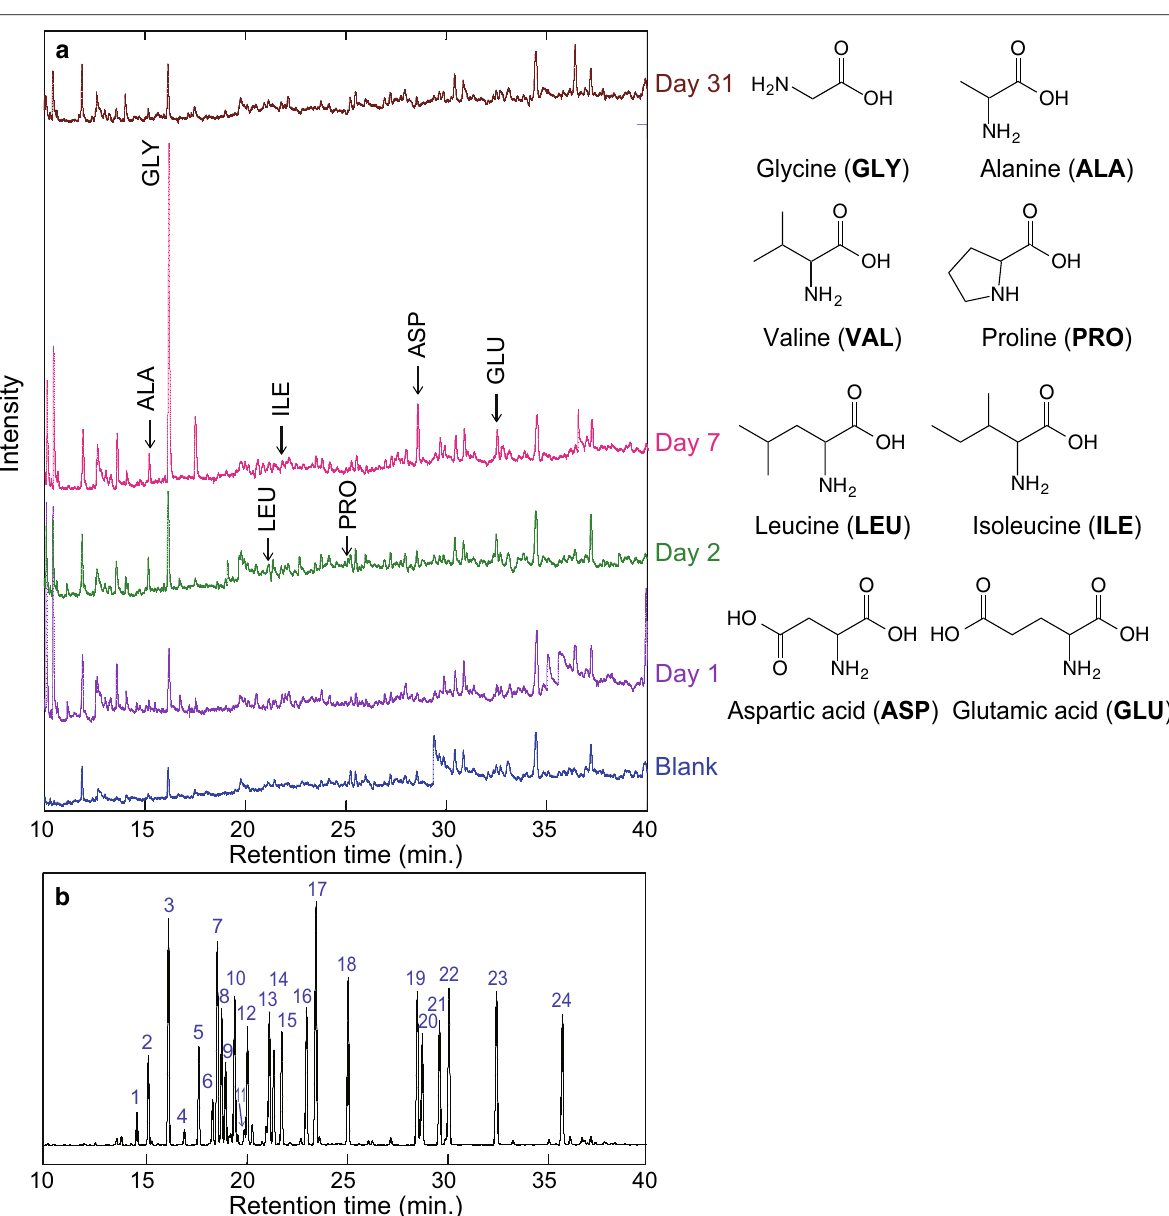
Fig. 3 a GC/NPD chromatograms of the witness coupons and chemical structures of the detected amino acids. b GC/NPD chromatograms of the authentic amino acid standards. The numbered peaks refer to the following: 1. α-aminoisobutyric acid; 2. α-alanine; 3. glycine; 4. isovaline; 5. α-aminobutyric acid; 6. sarcosine; 7. β-alanine; 8. β-aminobutyric acid; 9. valine; 10. β-aminoisobutyric acid; 11. N-ethylglycine; 12. norvaline; 13. leucine; 14. allo -isoleucine; 15. isoleucine; 16. norleucine; 17. γ-aminobutyric acid; 18. proline; 19. aspartic acid; 20. threonine; 21. serine; 22. methionine; 23. glutamic acid; 24. α-aminoadipic